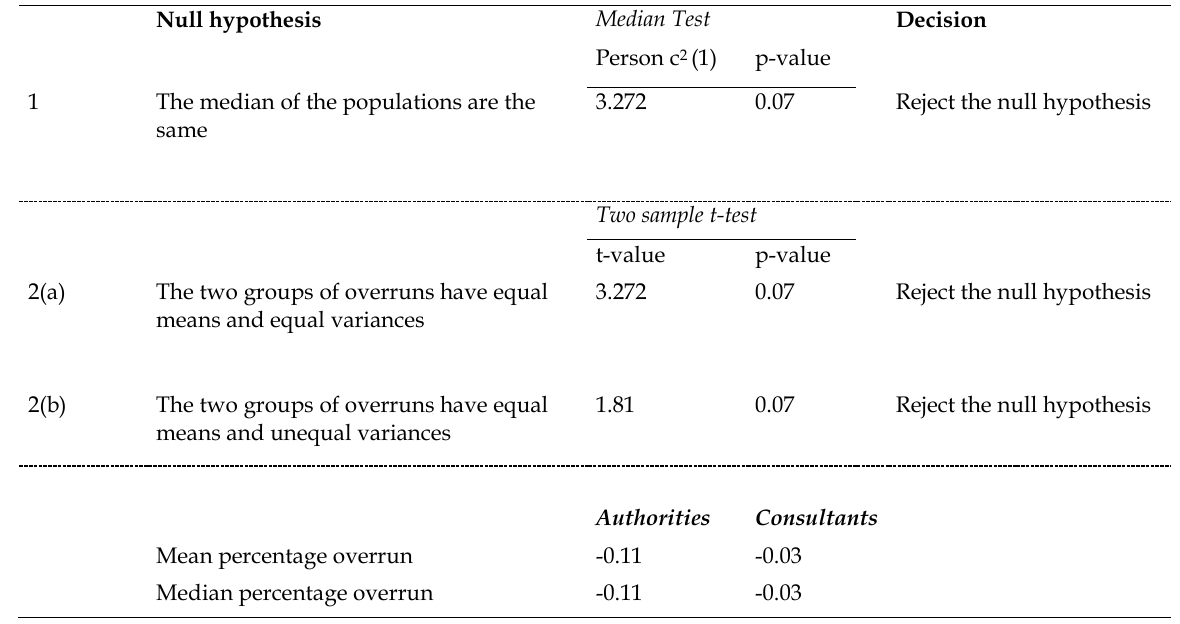
Table 6. Comparing the PCOs of road authorities and external consultant